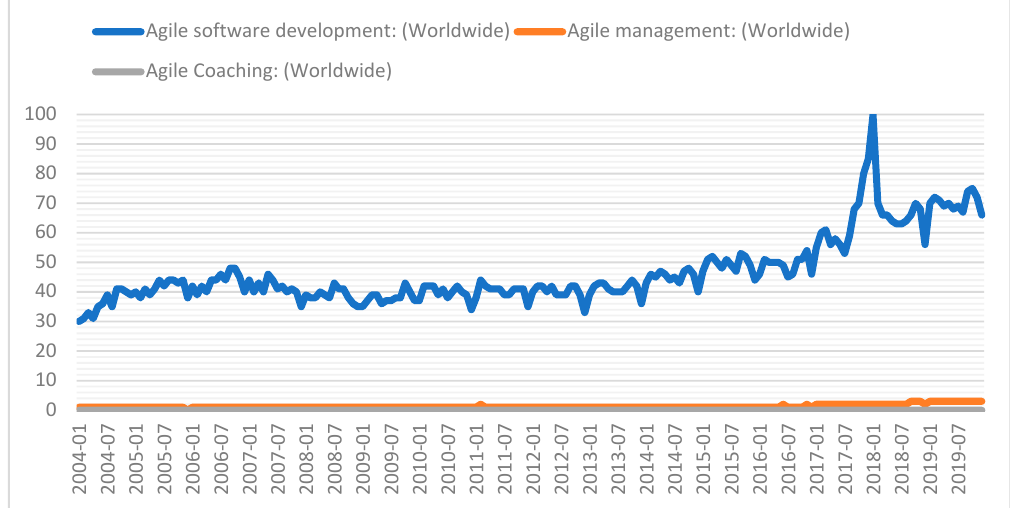
Figure 2. Google Trends for three types of Agile (data source: www.trends.google.com, retrieved 5 December 2019).